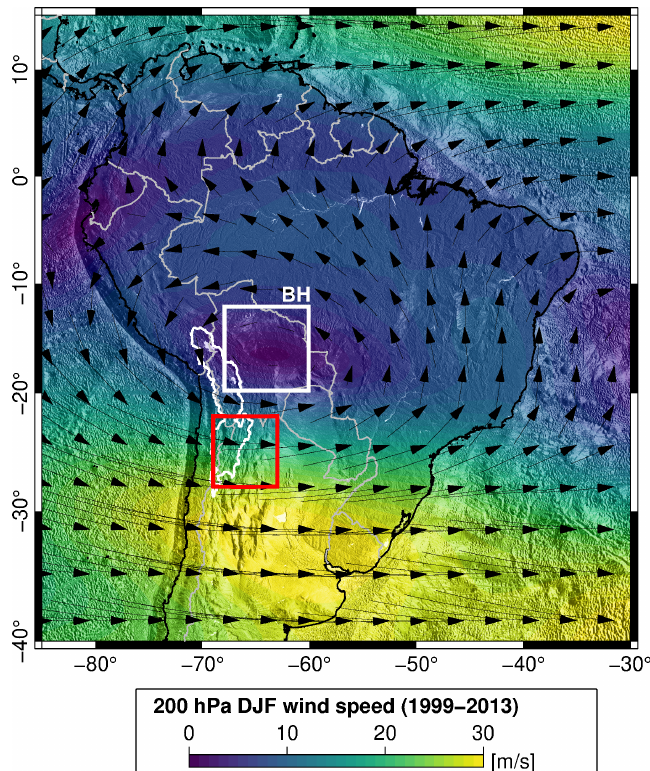
Figure 3. Average 200-hPa wind speed for DJF (1999–2013) based on ERA-interim reanalysis data shows the Bolivian High (BH), white box activity eastward of the south–central Andes ∼ 70 ◦ W and 17 ◦ S as well as the strong upper level westerlies in the study area (red box). These are often associated with deep convection. Black arrows and line indicate wind direction and are proportional to wind speed. White polygon outlines the central Andean